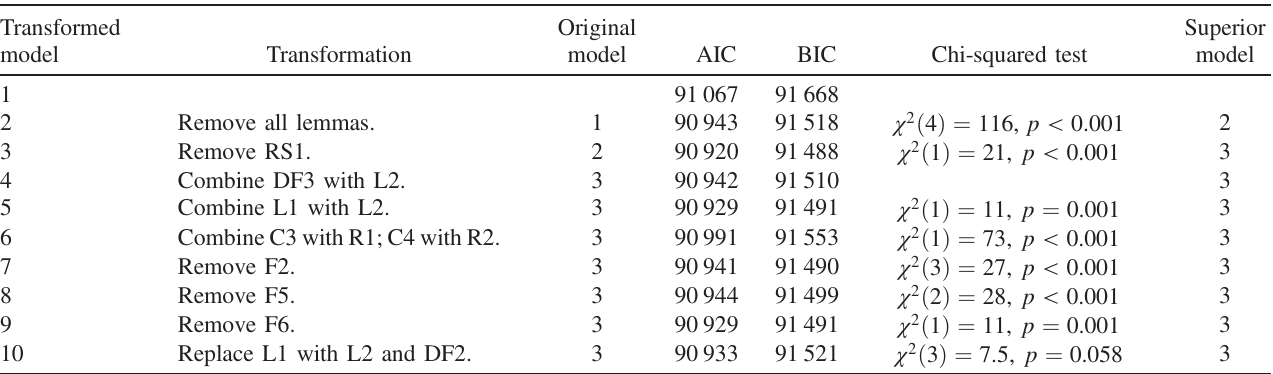
TABLE V. Hierarchical MIRT modeling. The χ 2 test determines whether the models are statistically different; if so, it measures the improvement of the superior model over the inferior